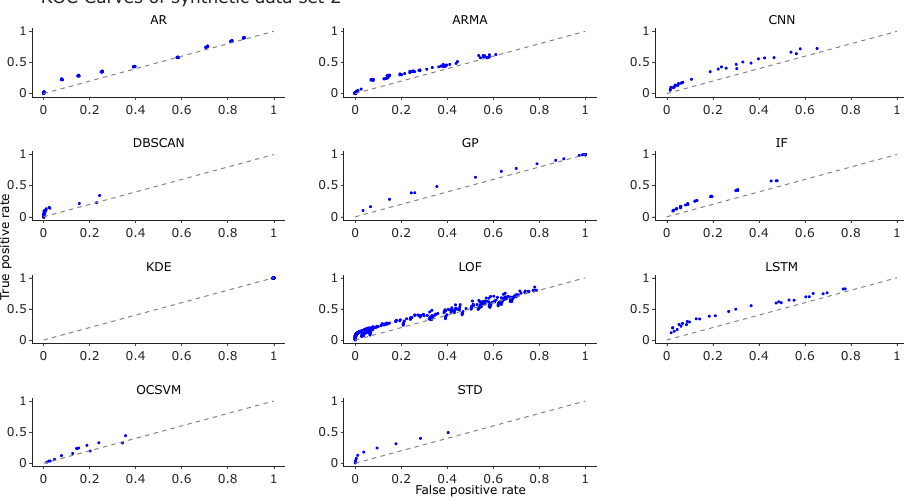
Figure A2. Results of the anomaly detection models based on synthetic data set